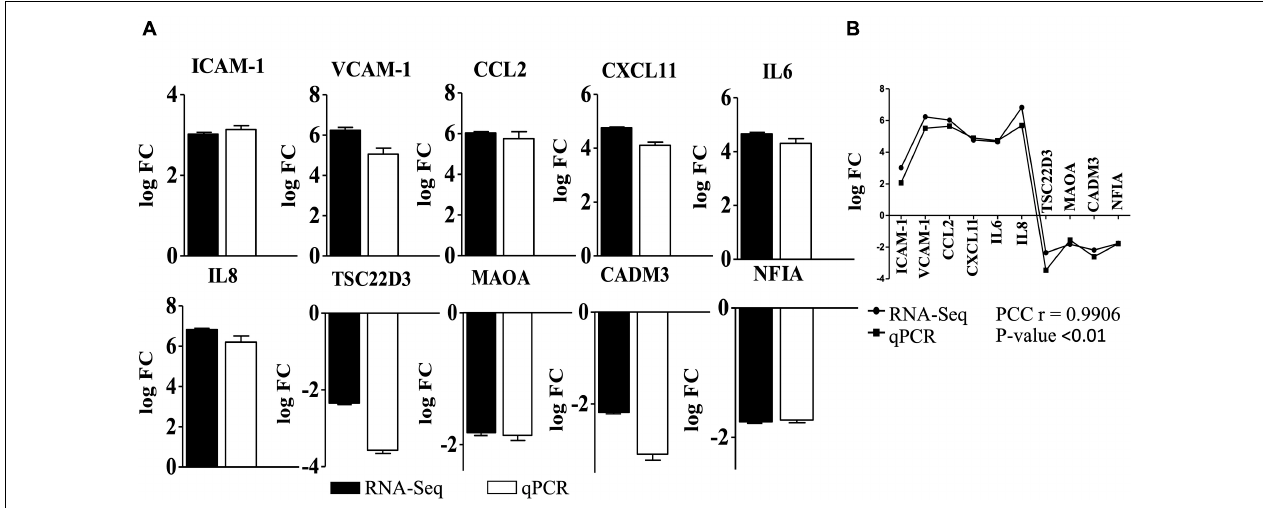
FIGURE 1 | Validation of differentially expressed genes detected in RNA-seq with qPCR. (A) Gene expression (logFC) of DEGs used to validate RNA-seq analysis of endothelial cells incubated with B. bavariensis . Black bars—logFC values from RNA-seq, white bars—log FC calculated from qPCR. Pearson correlation coefficient (PCC) r = 0.9906; P -value < 0.01. (B) Correlation of the gene expression (log FC) of DEGs obtained from RNA-seq and qPCR after incubation of hBMECs with B.